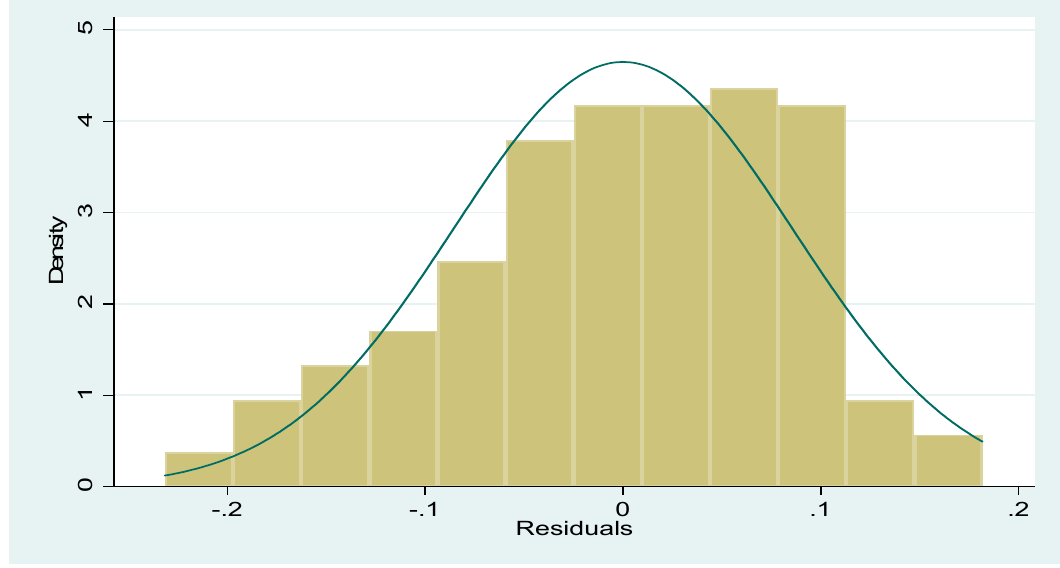
Figure 10. Residual normality plot—bell shaped histogram. Source: World Bank data group.